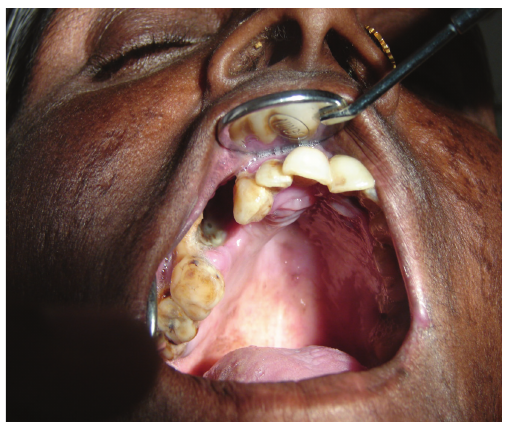
Figure 1: Clinical photograph showing oroantral fistula.